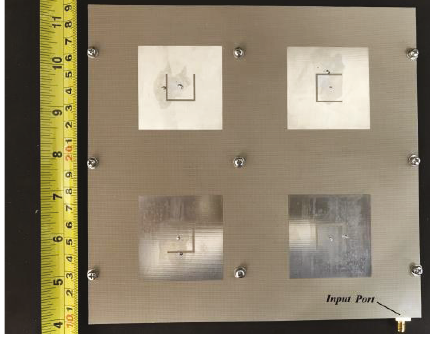
Figure 9: The fabricated prototype of the antenna array.